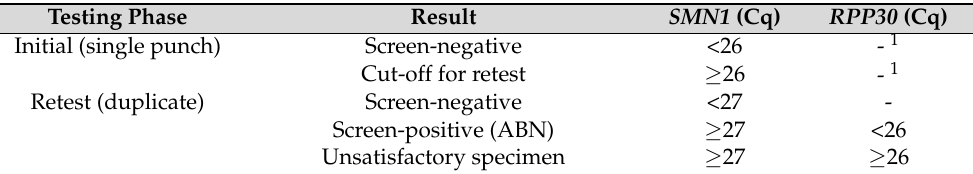
Table 1. Assay Cut-offs.